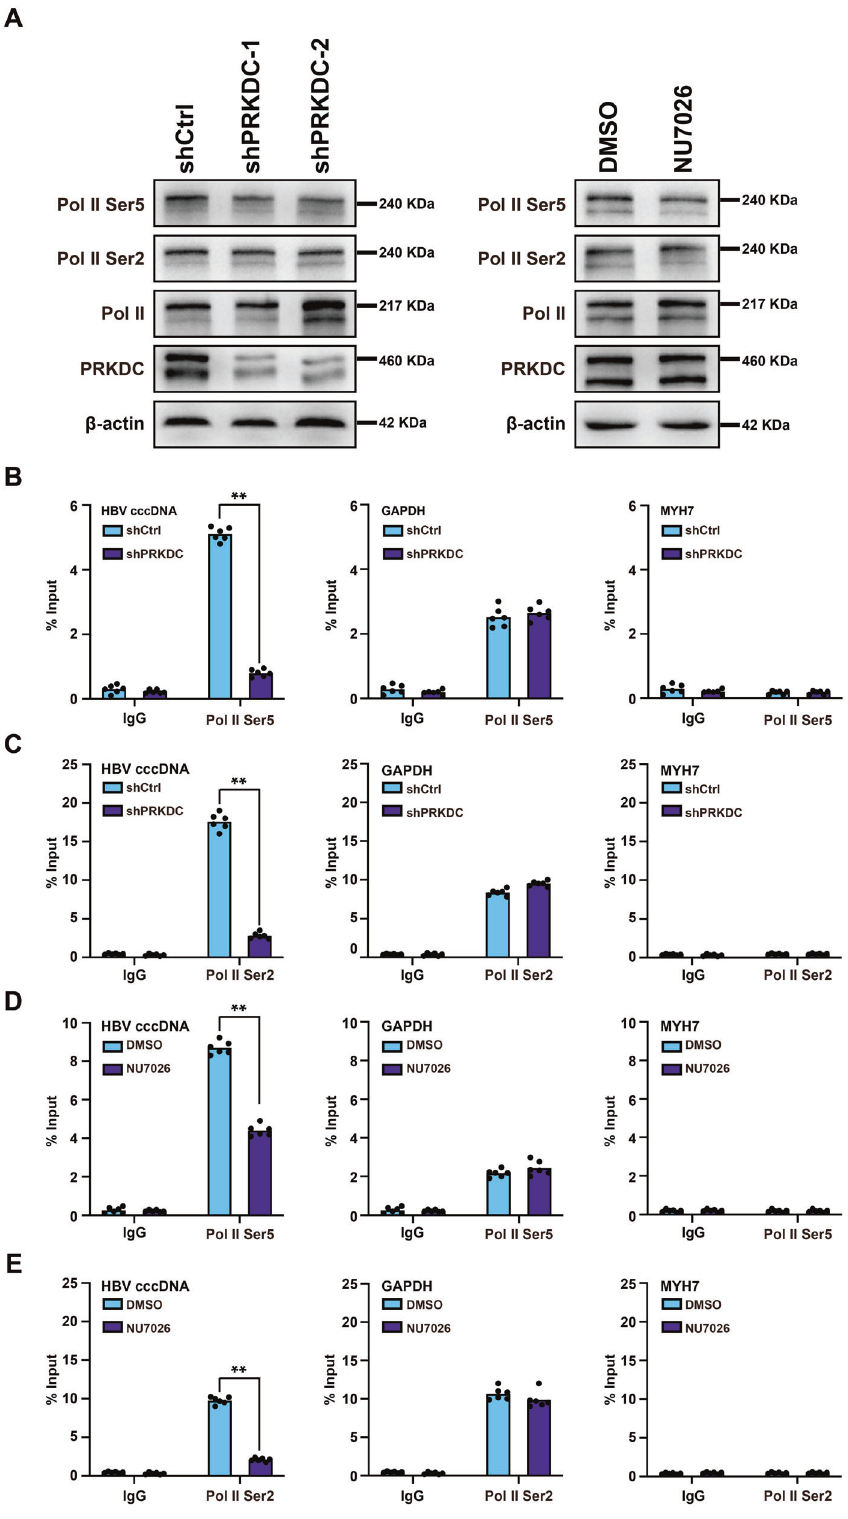
Fig. 7 cccDNA-associated Pol II CTD Ser2 and Ser5 phosphorylation modi fi cations decrease upon PRKDC depletion or NU7026 treatment. A Western blot analysis with antibodies against speci fi ed proteins. β -actin was used as a loading control. B , C Effects of PRKDC knockdown on the recruitment of Pol II Ser5 or Pol II Ser2 to cccDNA. The level of Pol II Ser5 ( B ) or Pol II Ser2 ( C ) associated with HBV cccDNA or the GAPDH or MYH7 promoter was analyzed by ChIP assay with the indicated antibodies. D , E NU7026 treatment in HBV-infected HepG2-NTCP cells correlated with decreased Pol II Ser5 and Pol II Ser2 binding. The level of Pol II Ser5 ( D ) or Pol II Ser2 ( E ) associated with HBV cccDNA or the GAPDH or MYH7 promoter was analyzed by ChIP assay. The results are displayed as the percentage of input. ** P < 0.01.